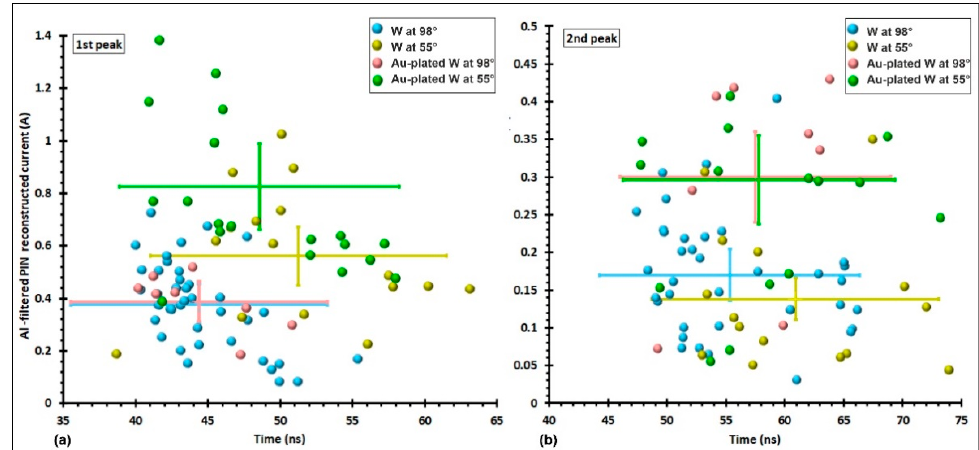
Figure 5. Reconstructed PIN diode current values as a function of time for all of the X-pinch configurations, for the ( a ) first and ( b ) second peaks.